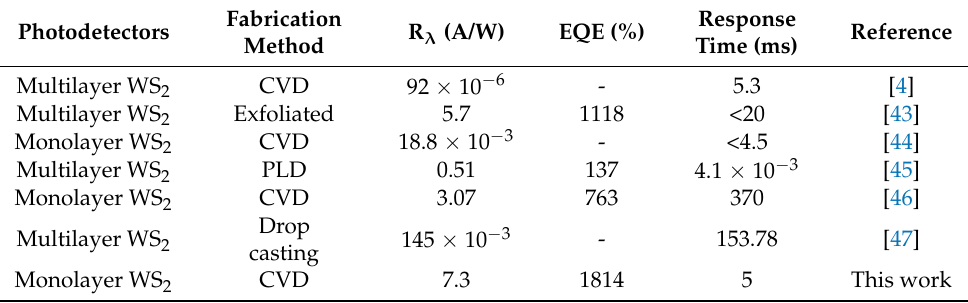
Figure 5. Optoelectronic properties of the WS 2 triangle flake. ( a ) The spectral response curve of the WS 2 triangle flake. Inset: the fitting curve of obtaining the bandgap. ( b ) Photocurrent as a function of illumination intensity at V bias = 1 V. Inset: the optical image of the WS 2 photodetector; the scale bar is 10 µ m. ( c ) Time-resolved photoresponse of the WS 2 photodetector under a bias voltage of 1 V and illumination power of 3.68 mW · cm − 2 . ( d ) Response and recovery curves. Table 1. Comparison of the key parameters of our